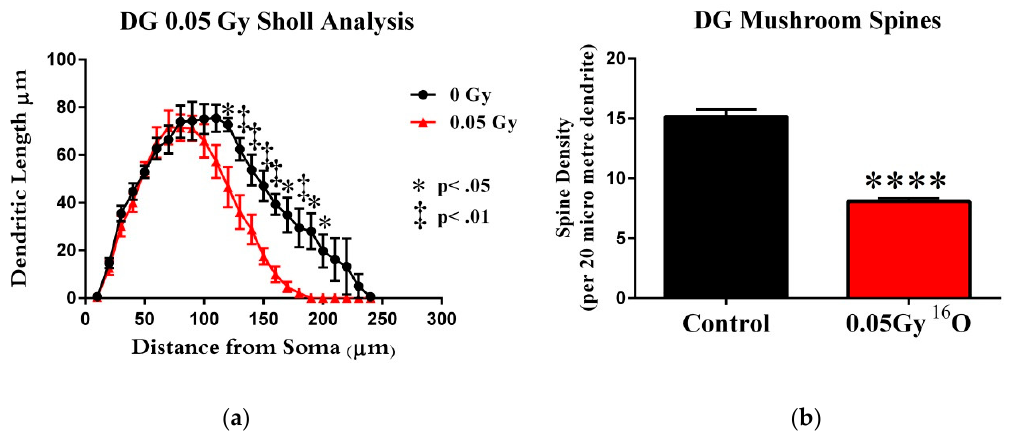
Figure 3. Dentate gyrus (DG) dendrite and spine morphology. ( a ) Dendritic length reduces significantly due to 0.05 Gy of 16 O. ( b ) Irradiation significantly reduced mushroom spine density in the DG. Average ± SEM ( n = 5); **** p < 0.0001. Table 1. Effects of 16 O on dendrite morphology in the DG.